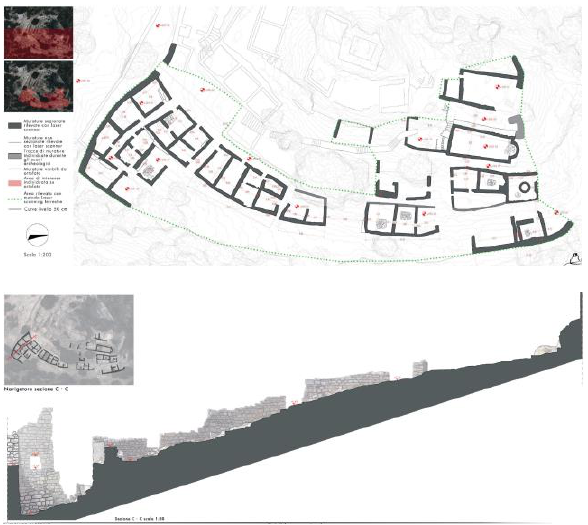
Figure 16. The Bianchi typologies classification transposed in the 3D model of a portion of Rocca di San Silvestro.